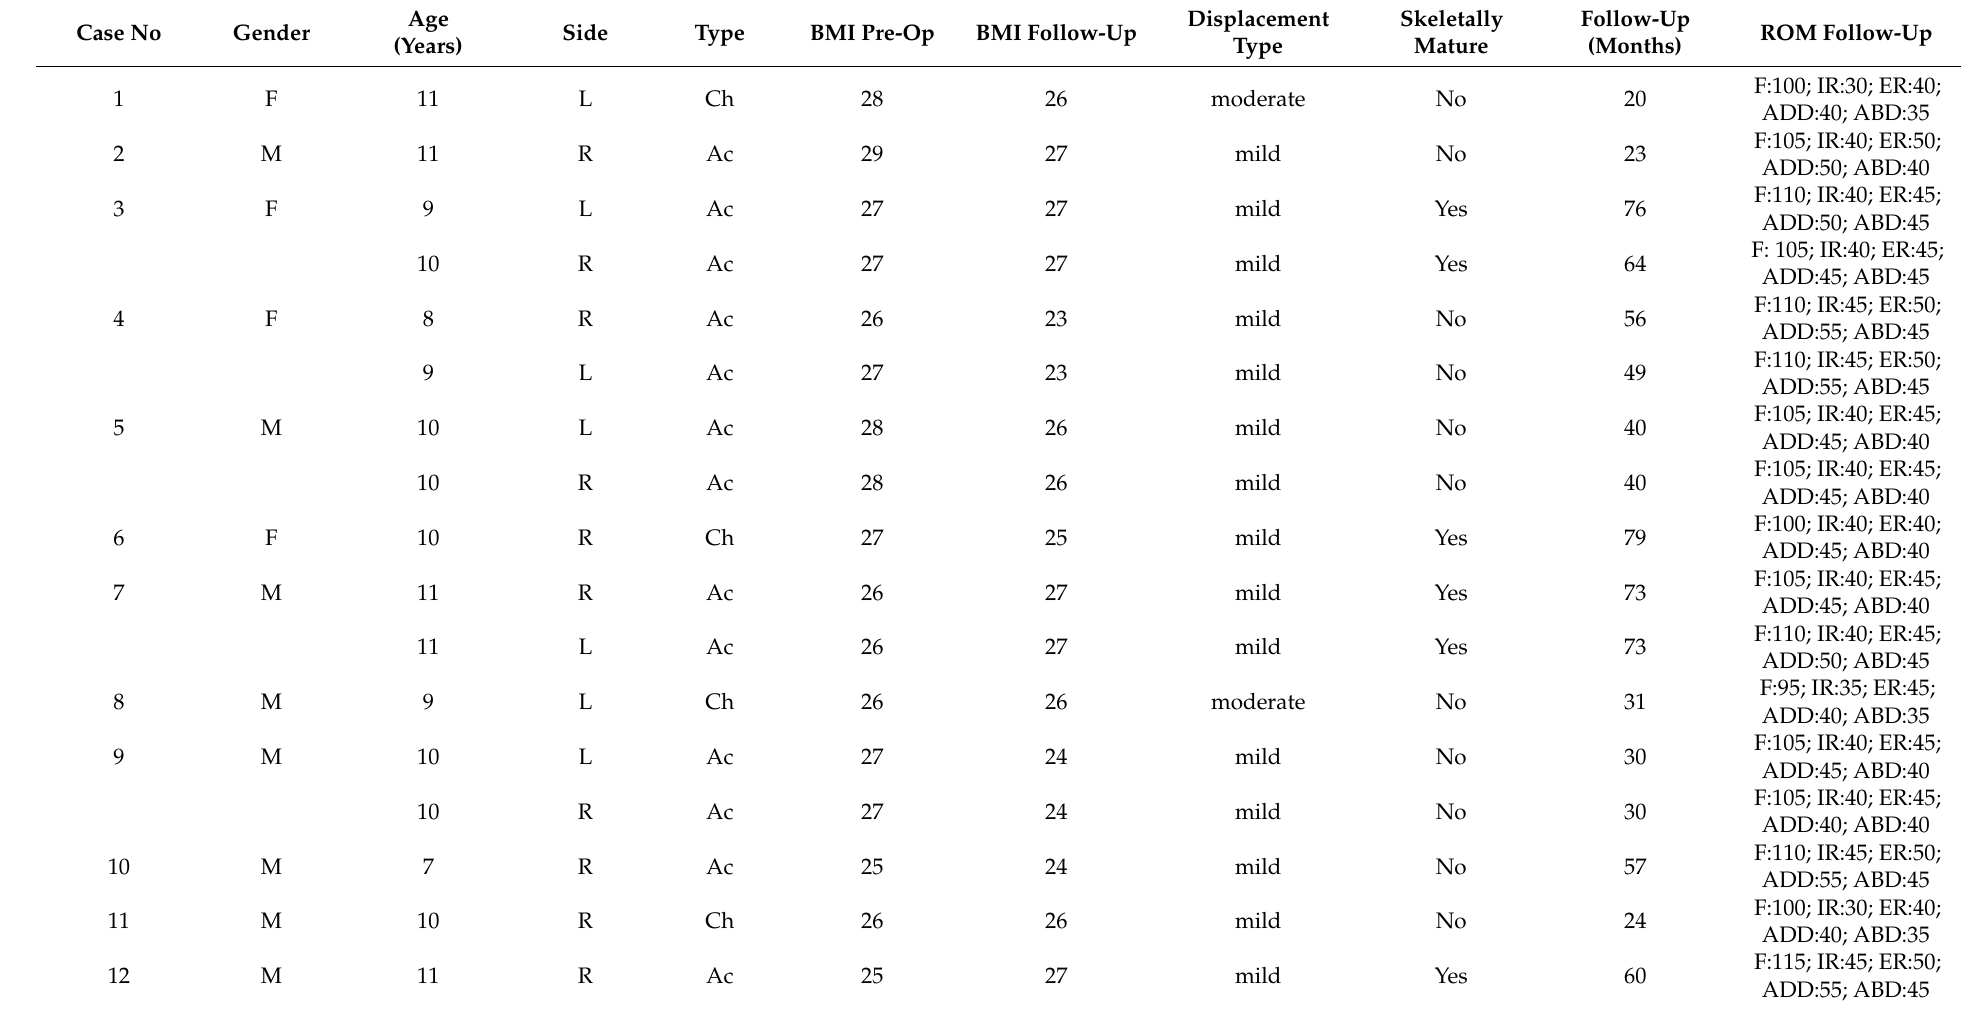
Table 1. Summary of Demographic Data and Results; M-male; F-female; L-left; R-right; Ac-acute; Ch-chronic; F-flexion of the hip; IR-internal rotation; ER-external rotation; ADD-adduction;